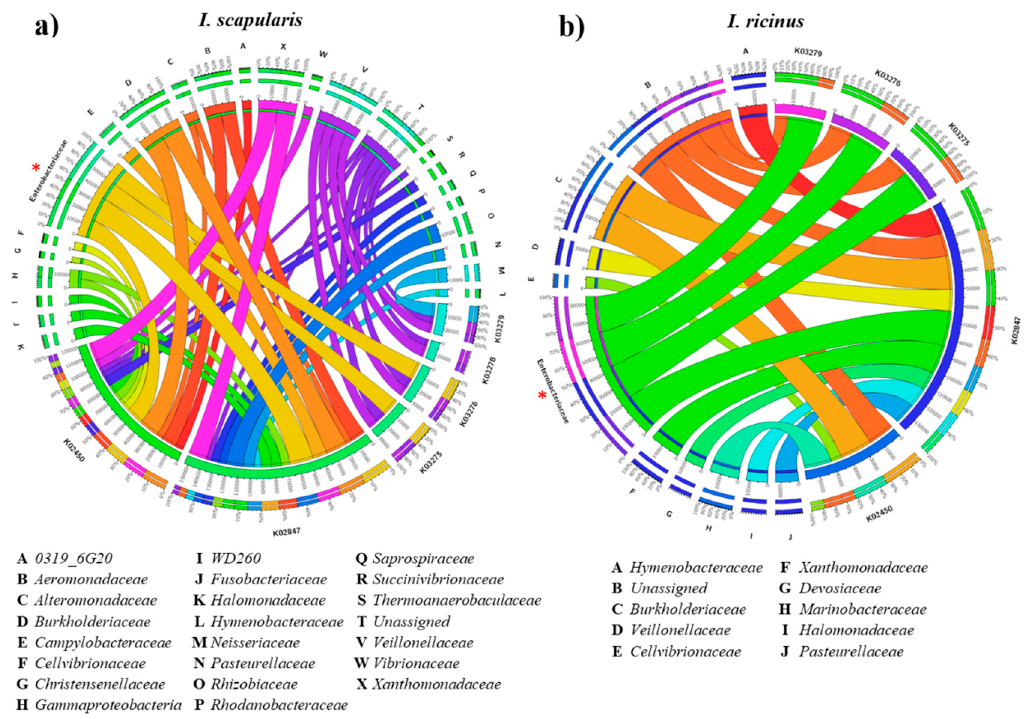
Figure 3. Metagenome contribution to α 1,3-galactosyltransferase genes in the gut microbiota of ( a ) I. scapularis , and ( b ) I. ricinus nymphs. The position of Enterobacteriaceae was highlighted (red *). KEGG orthology and taxonomic contribution was predicted using PICRUSt2. Chord diagrams show the linkage between classified and unclassified (unassigned) taxa and α 1,3-galactosyltransferase genes. The arcs indicate connections, represented proportionally by the size of each arc. Node segments along a circle represent taxa or functional genes, the node size indicates the abundance (measured as feature count) of contributing taxa and genes. Chord diagrams were made with the visualization tool “Circos” [37].